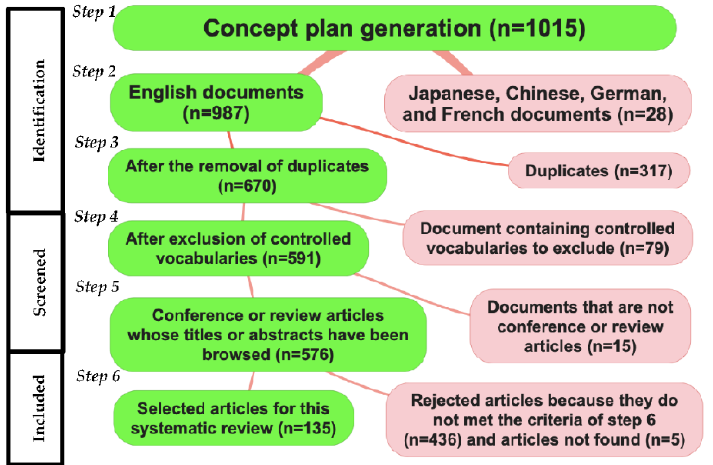
Figure 3. Article selection strategy. The green boxes justify the considered articles. The red boxes justify the ejected articles.